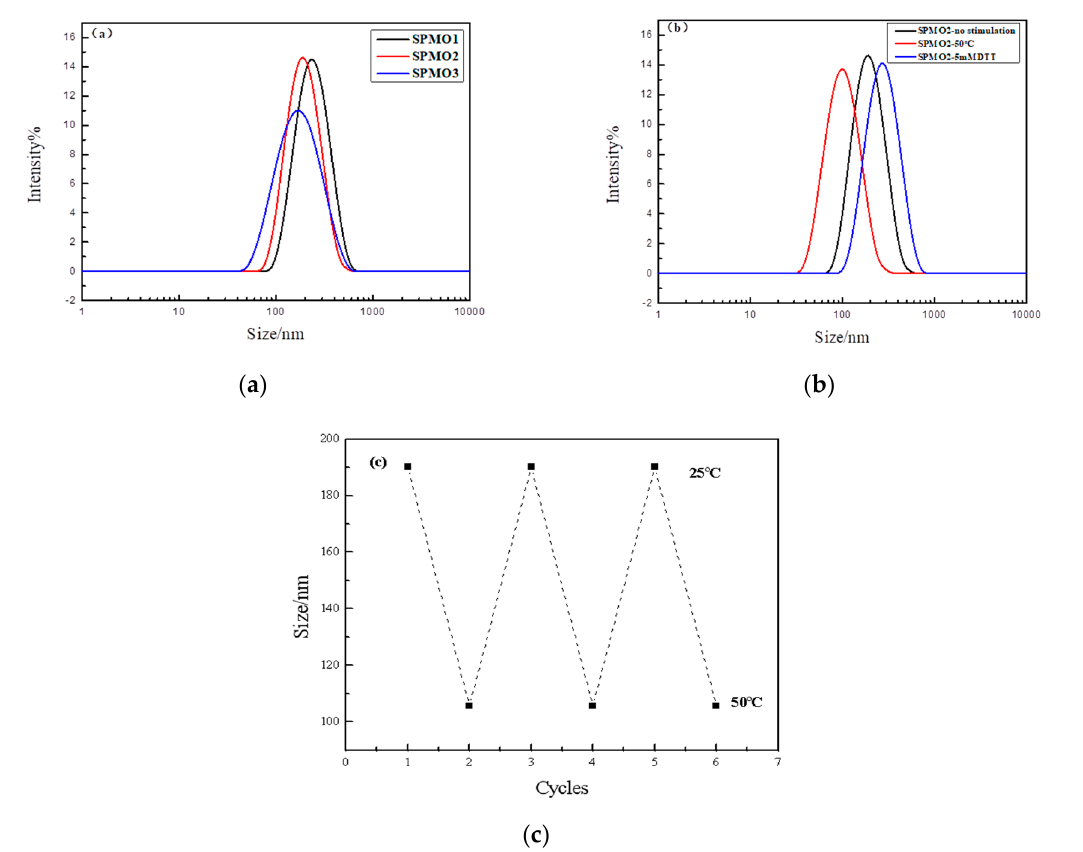
Figure 7. ( a ) Size distributions of SPMO aqueous solutions (1 mg/mL) with different DP. ( b ) The SPMO2 aqueous solutions (1 mg/mL) under different stimulation. ( c ) Average hydrodynamic diameter of SPMO2 aqueous solution (1 mg/mL) during heating and cooling cycles.